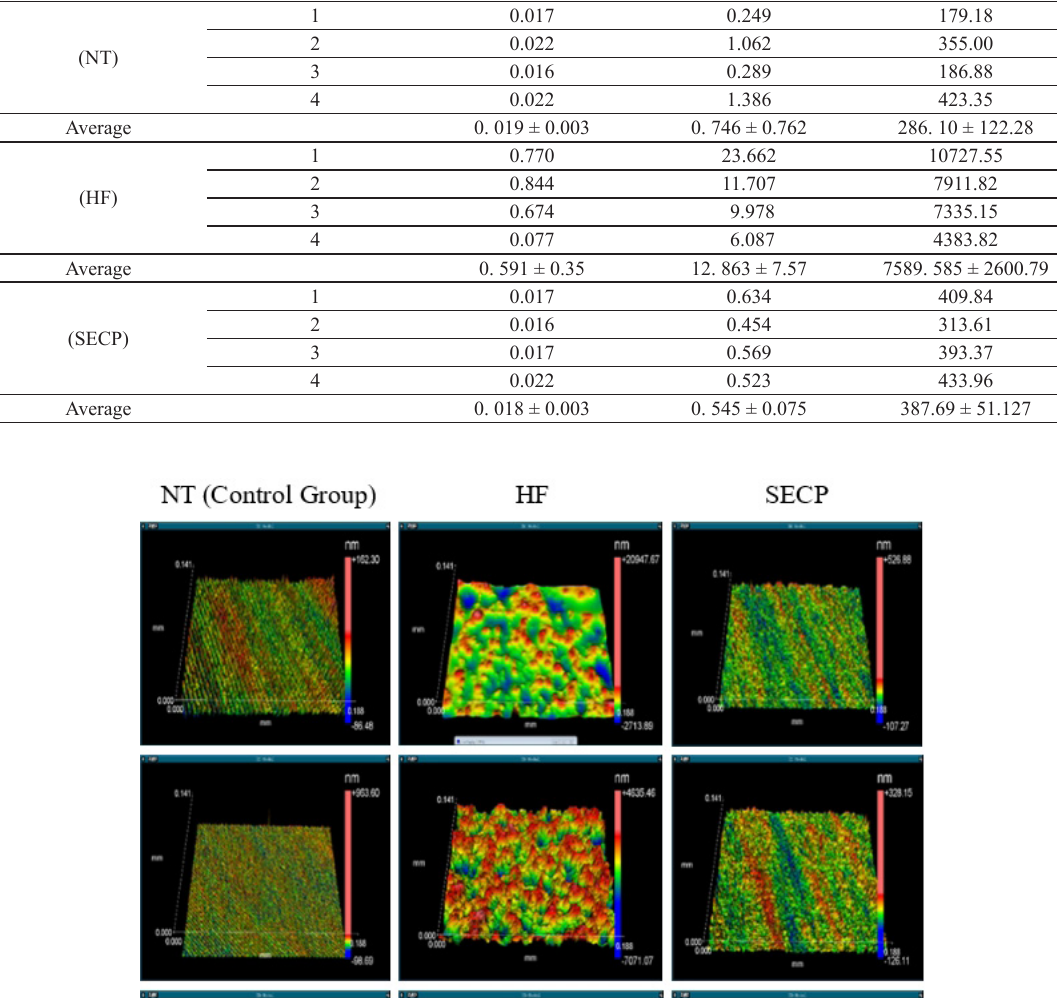
Table 3. Surface roughness parameters (Ra), maximum peak value (Peak) and minimum valley value (Valley) of lithium disilicate samples - no surface treatment (NT), hydrofluoric acid etching (HF) and pre-treatment with Monobond Etch and Prime (SECP). Group